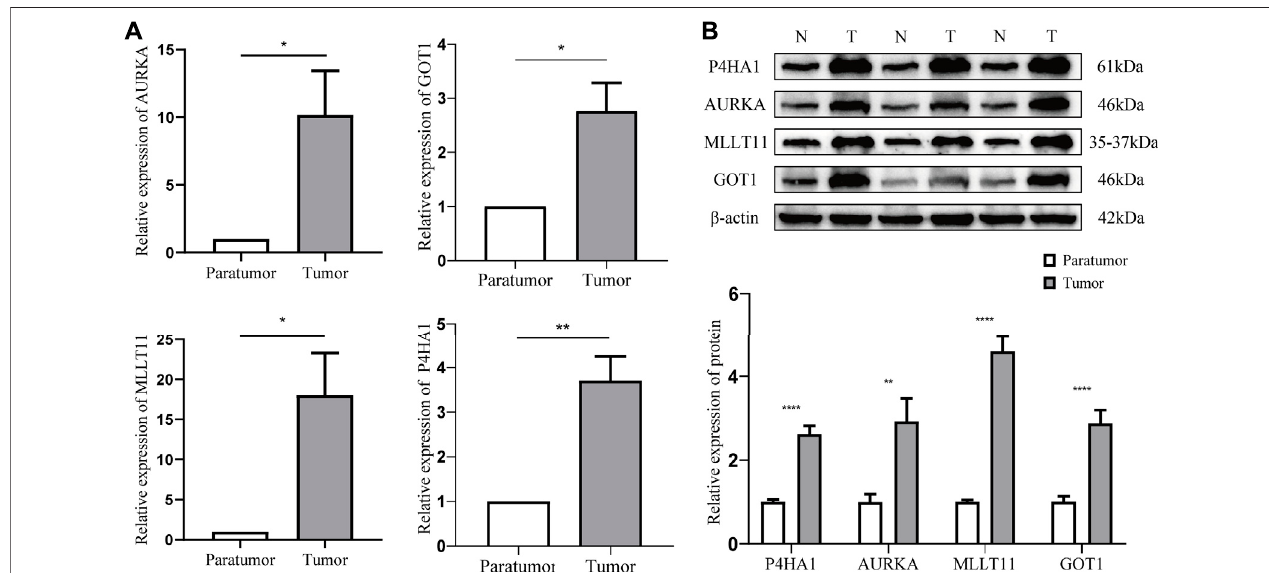
FIGURE 7 | Expression validation of prognostic biomarkers in clinical samples. (A) Expressions of P4HA1, MLLT11, AURKA, and GOT1 in tumor and paratumor samplesbyRT-qPCR. (B) Expressionsandquanti fi cationresultofP4HA1,MLLT11,AURKA,andGOT1intumorandparatumorsamplesbyWesternblot.*, p < 0.05vs. control; **, p < 0.01 vs. control; ***, p < 0.001; ****, p <